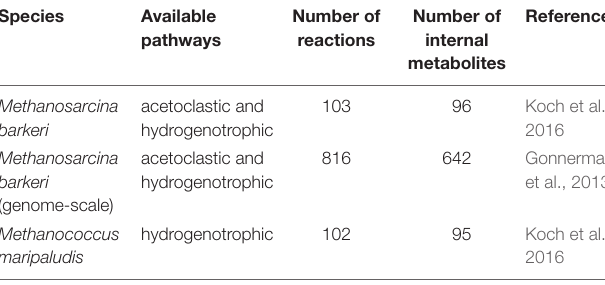
TABLE 1 | Models of methanogenic species used.